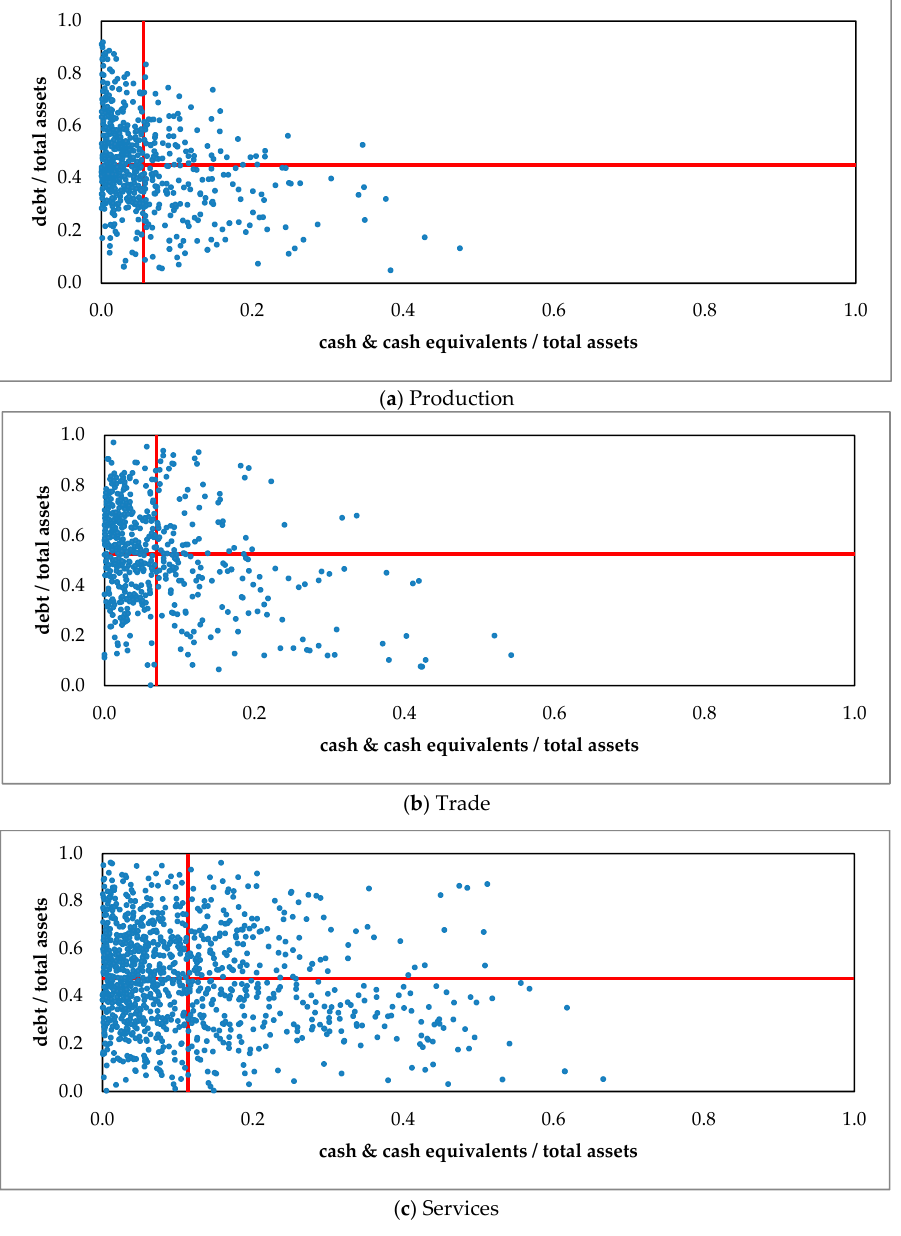
Figure 3. Dispersion of debt capacity constraint (debt to total assets) and liquidity constraint (cash and cash equivalents to total assets) in the examined sample, broken by sectors: production (N = 665), services (N = 1071) and trade (N = 566). Red lines reflect the mean values.